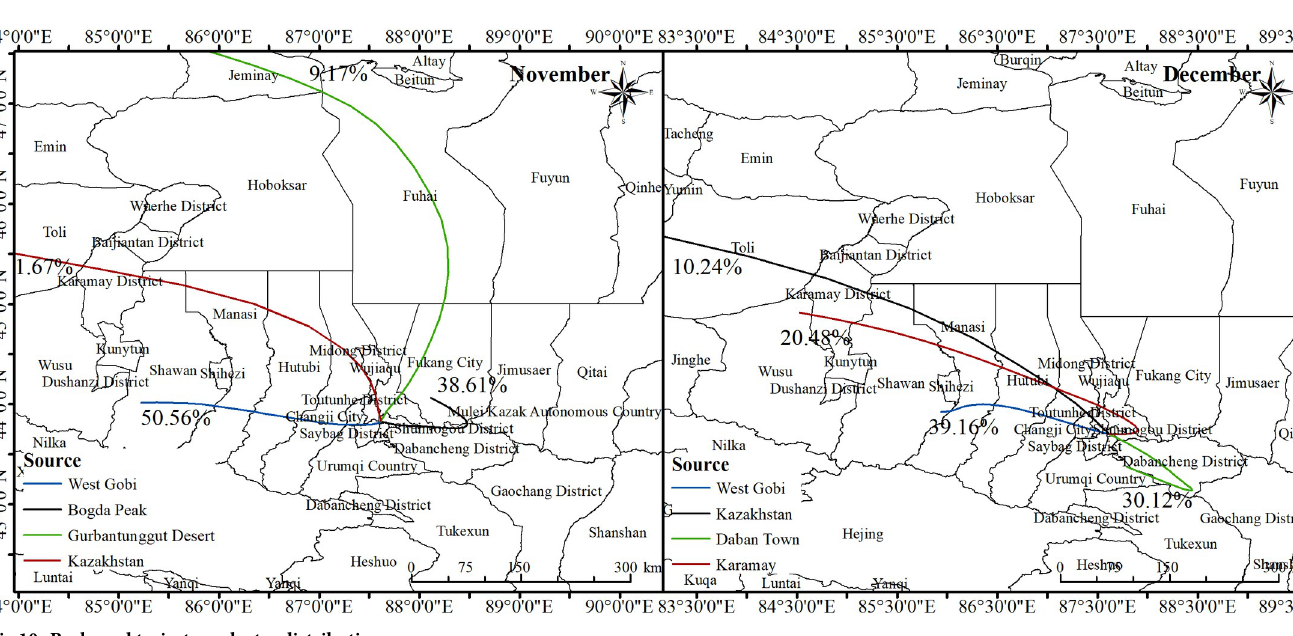
PLOS ONE | https://doi.org/10.1371/journal.pone.0249563 April 20, 2021 14 /